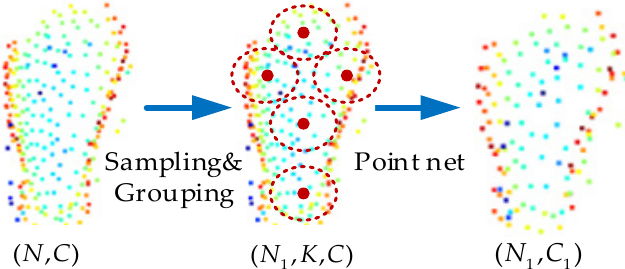
Figure 4. The structure of a set abstraction. The farthest point sampling method is used to sample feature points and group them, and a set of Pointnets is used to extract the features of each local region.